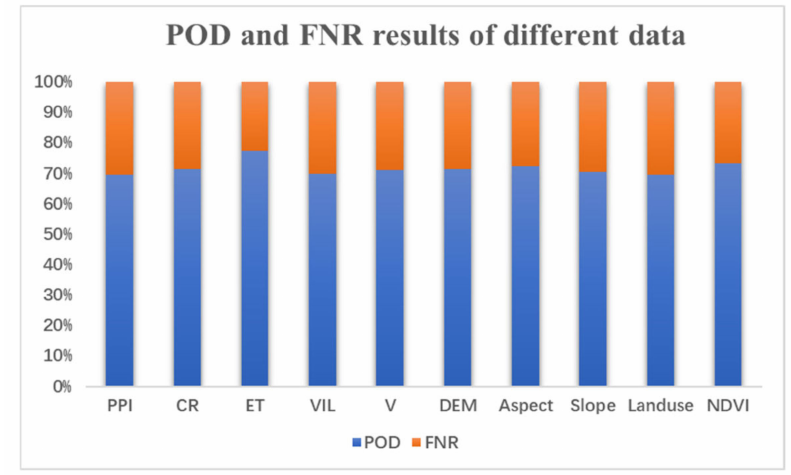
Figure 9. POD and FNR results of different data